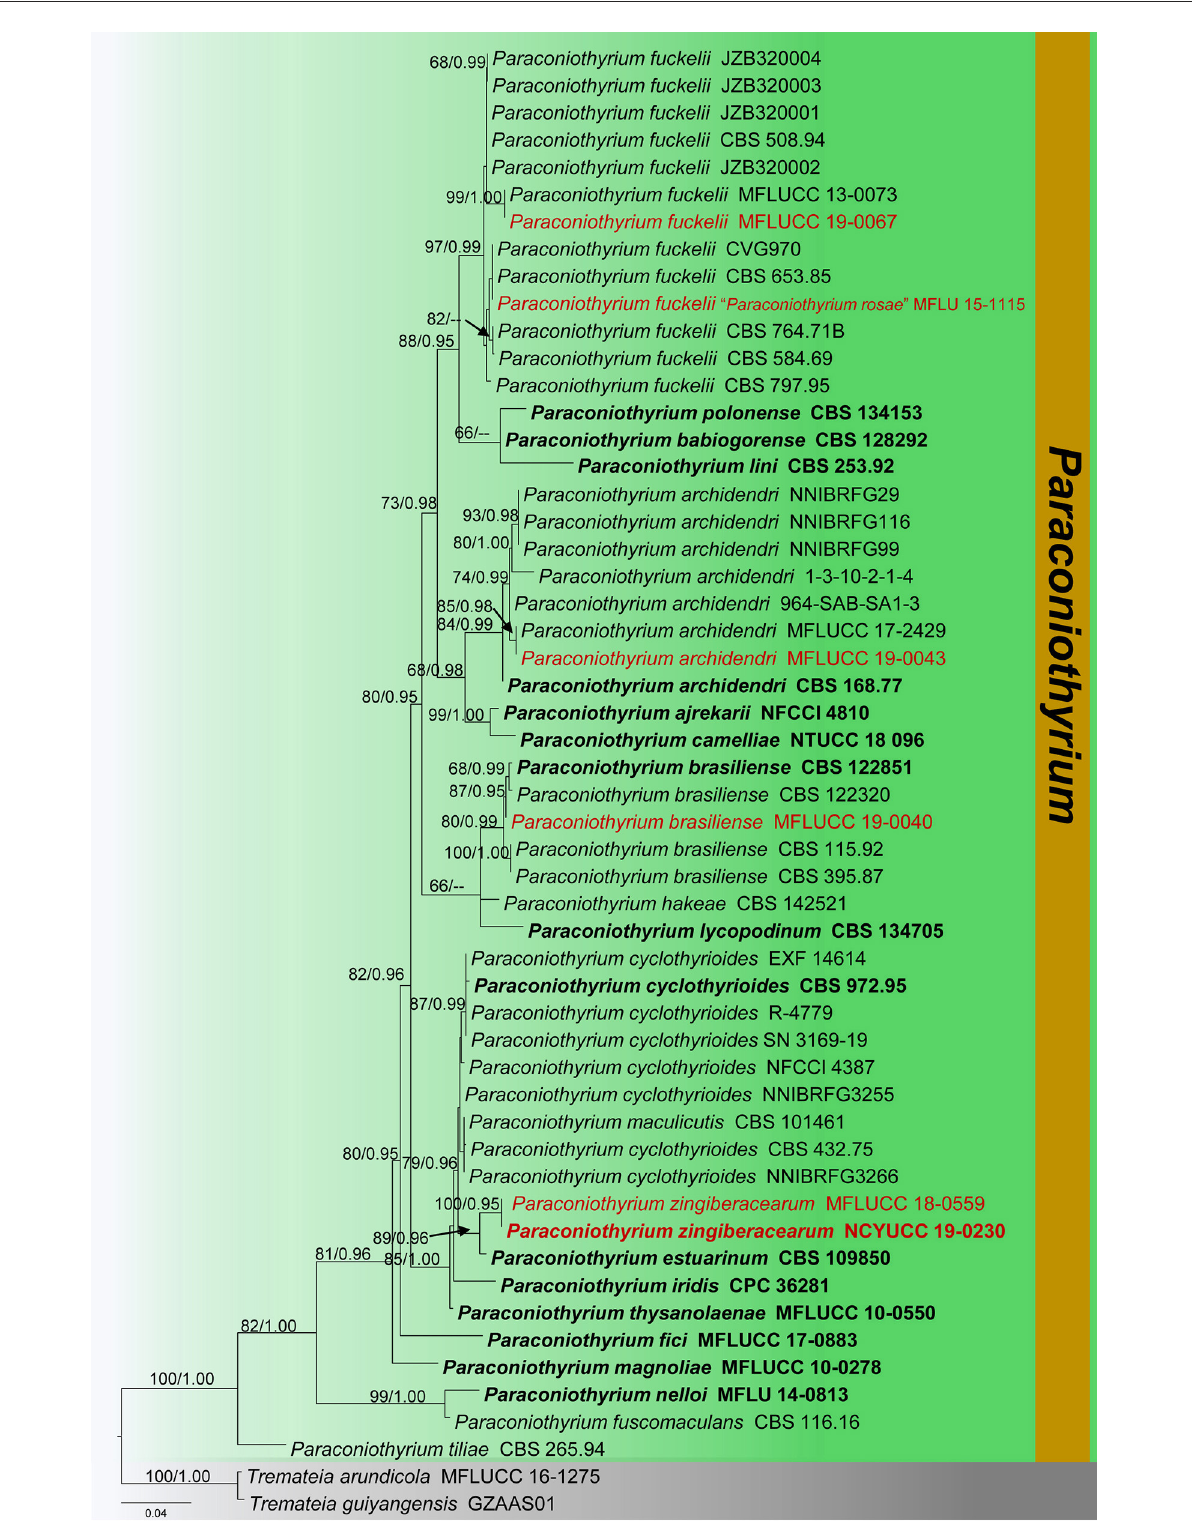
FIGURE4 Phylogram generated from maximum likelihood analysis is based on combined ITS, LSU, and tub2 sequence data (final likelihood value of − 8278.609544). The tree is rooted with Tremateia arundicola and T . guiyangensis (MFLUCC 16-1275 and GZAAS01). The ex-type strains are indicated in bold, and the new isolates are indicated in red. Bootstrap support values ≥ 65% of maximum likelihood (ML) and Bayesian posterior probabilities (PP) values ≥ 0.90 are given above the